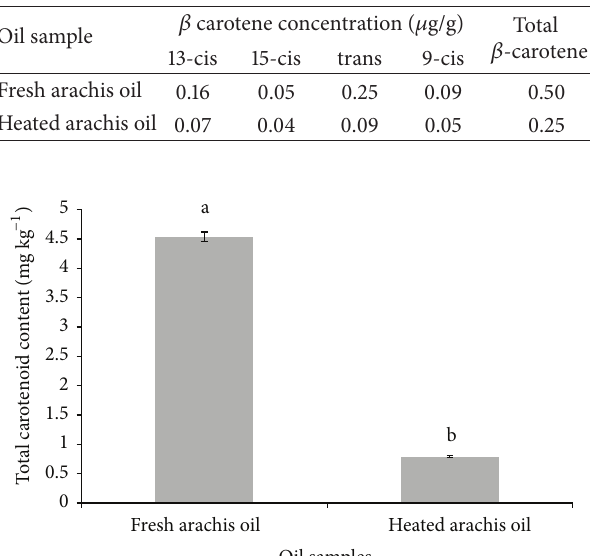
Table 1: Effect of thermal oxidation on the concentration of 𝛽 - carotene in arachis oil.